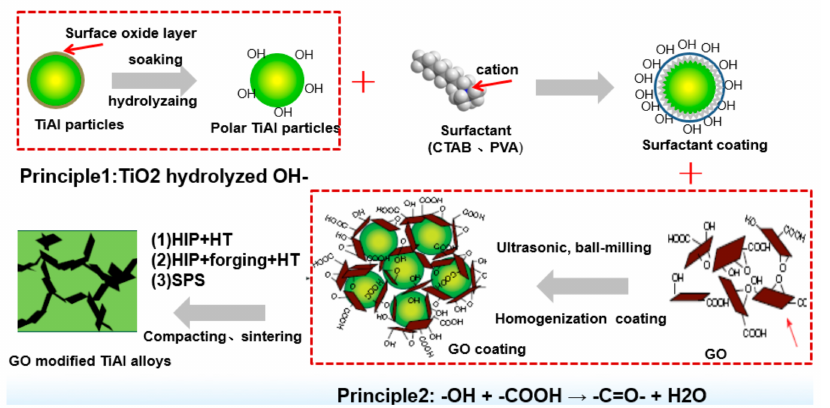
Figure 1. GO-imbedded TiAl matrix